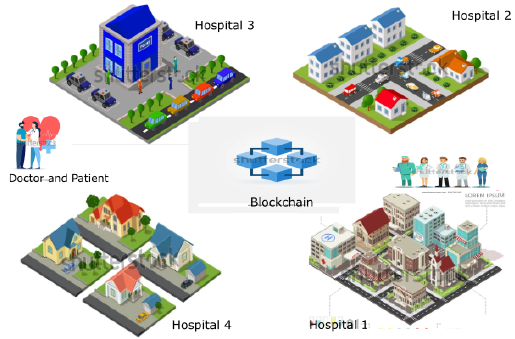
Figure 3. Cross-Domain Blockchain-based Healthcare System.